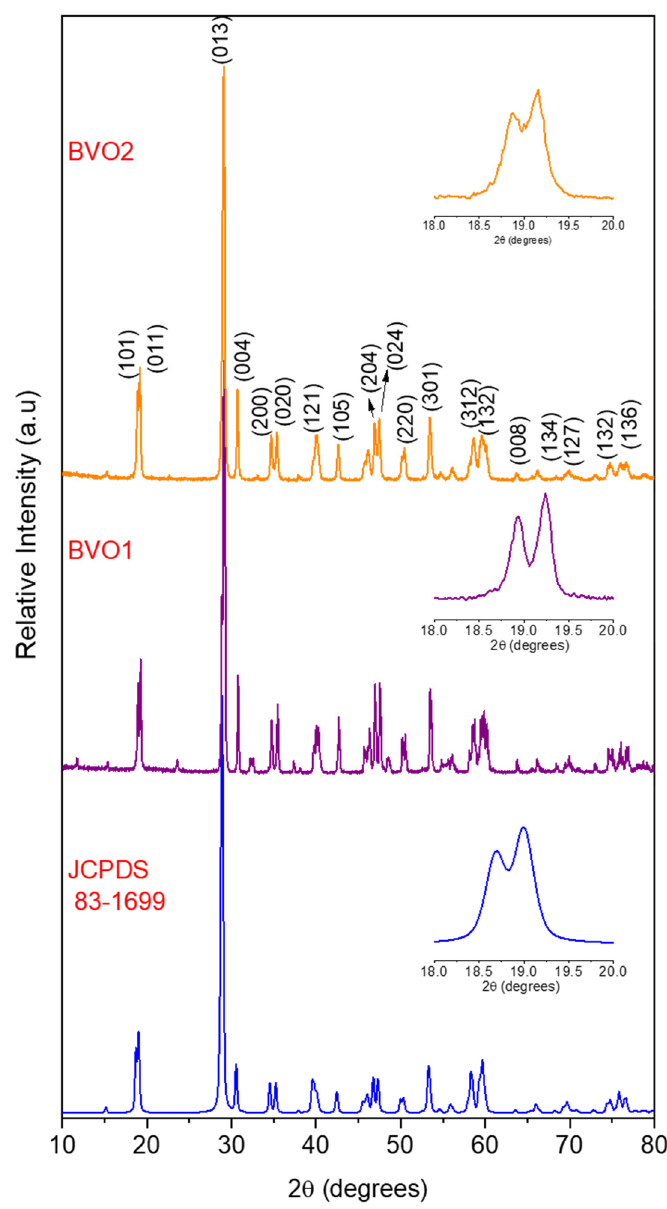
Figure 2. X-ray diffractogram of bismuth vanadate (BVO) before (BVO1) and after (BVO2) thermal treatment at 300 °C for 24 h.